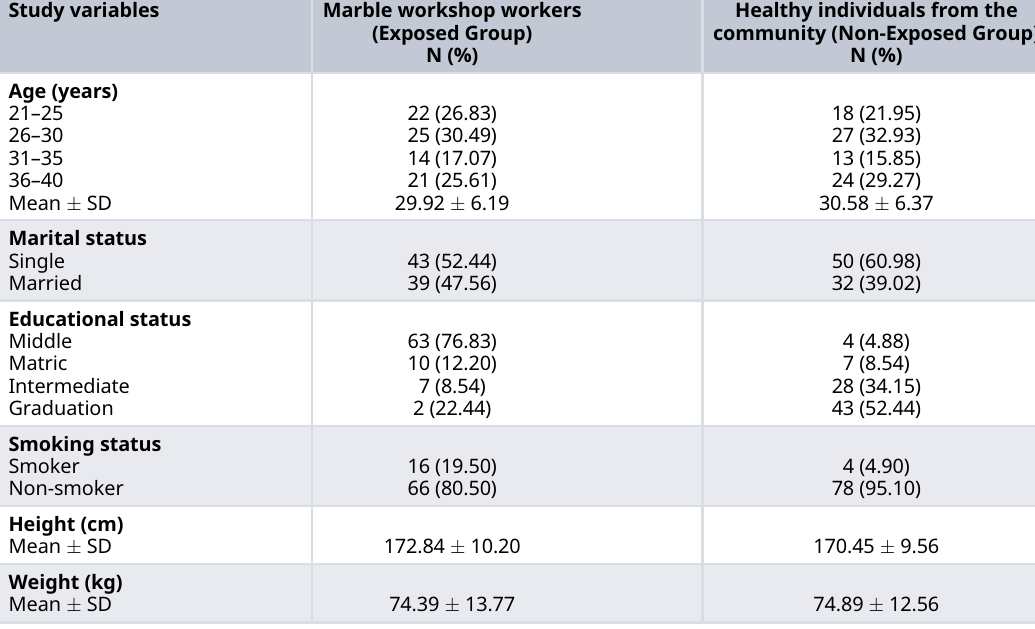
Figure 1 presents operational definitions of pulmonary impairment as recommended by spirometry flow chart for diagnosis (reference). The underlying study data (Table 1: Data Marble Feb 19 2021.sav) is available at Figshare. 35